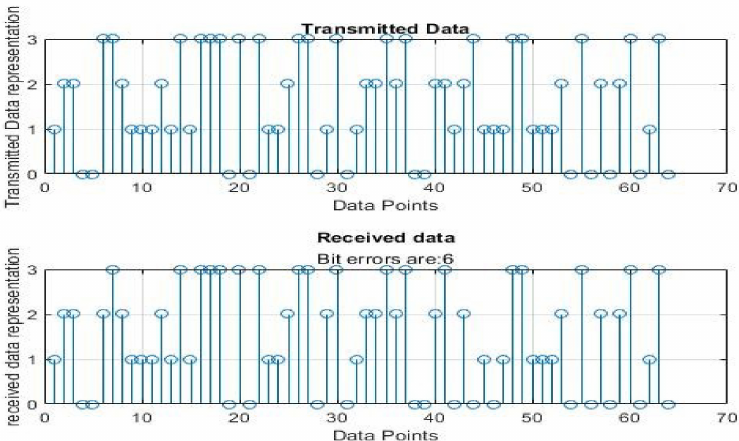
Figure 11. Customary QPSK output for 64 data points in a noisy